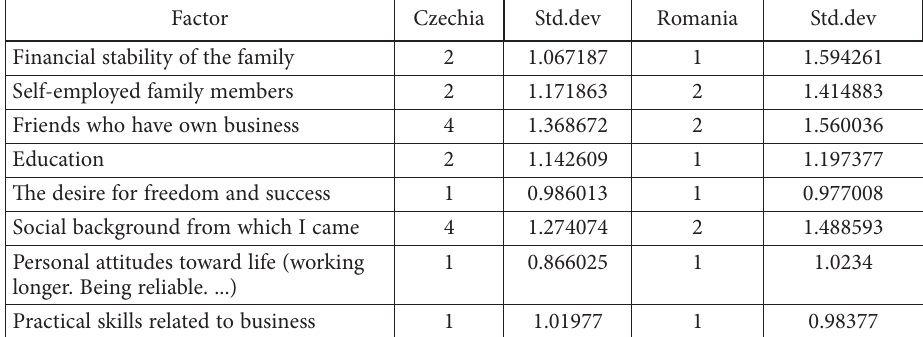
Table 5. Motivation to start-up – A student view (survey data mode values, differences are in bold) Factor Czechia Std.dev Romania